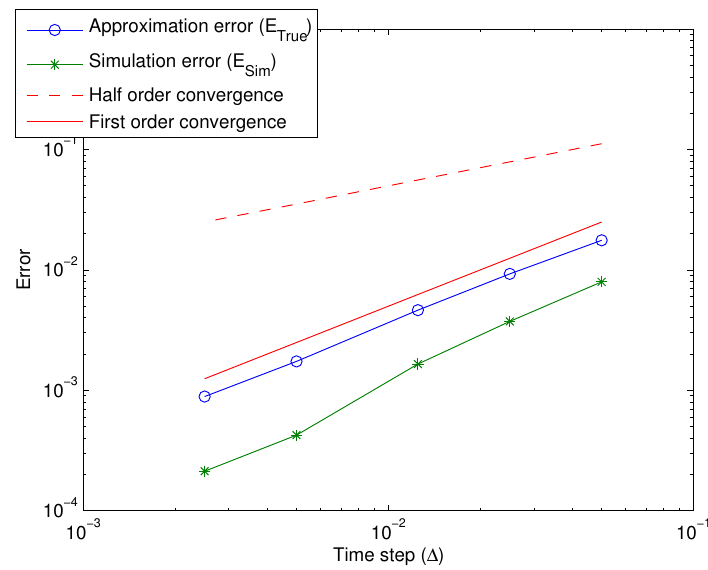
Figure 2. Log-log plot of errors using the 1-stage Runge–Kutta scheme. The sample standard deviation of the error E Sim was less than 2 × 10 − 6 for all time discretizations.